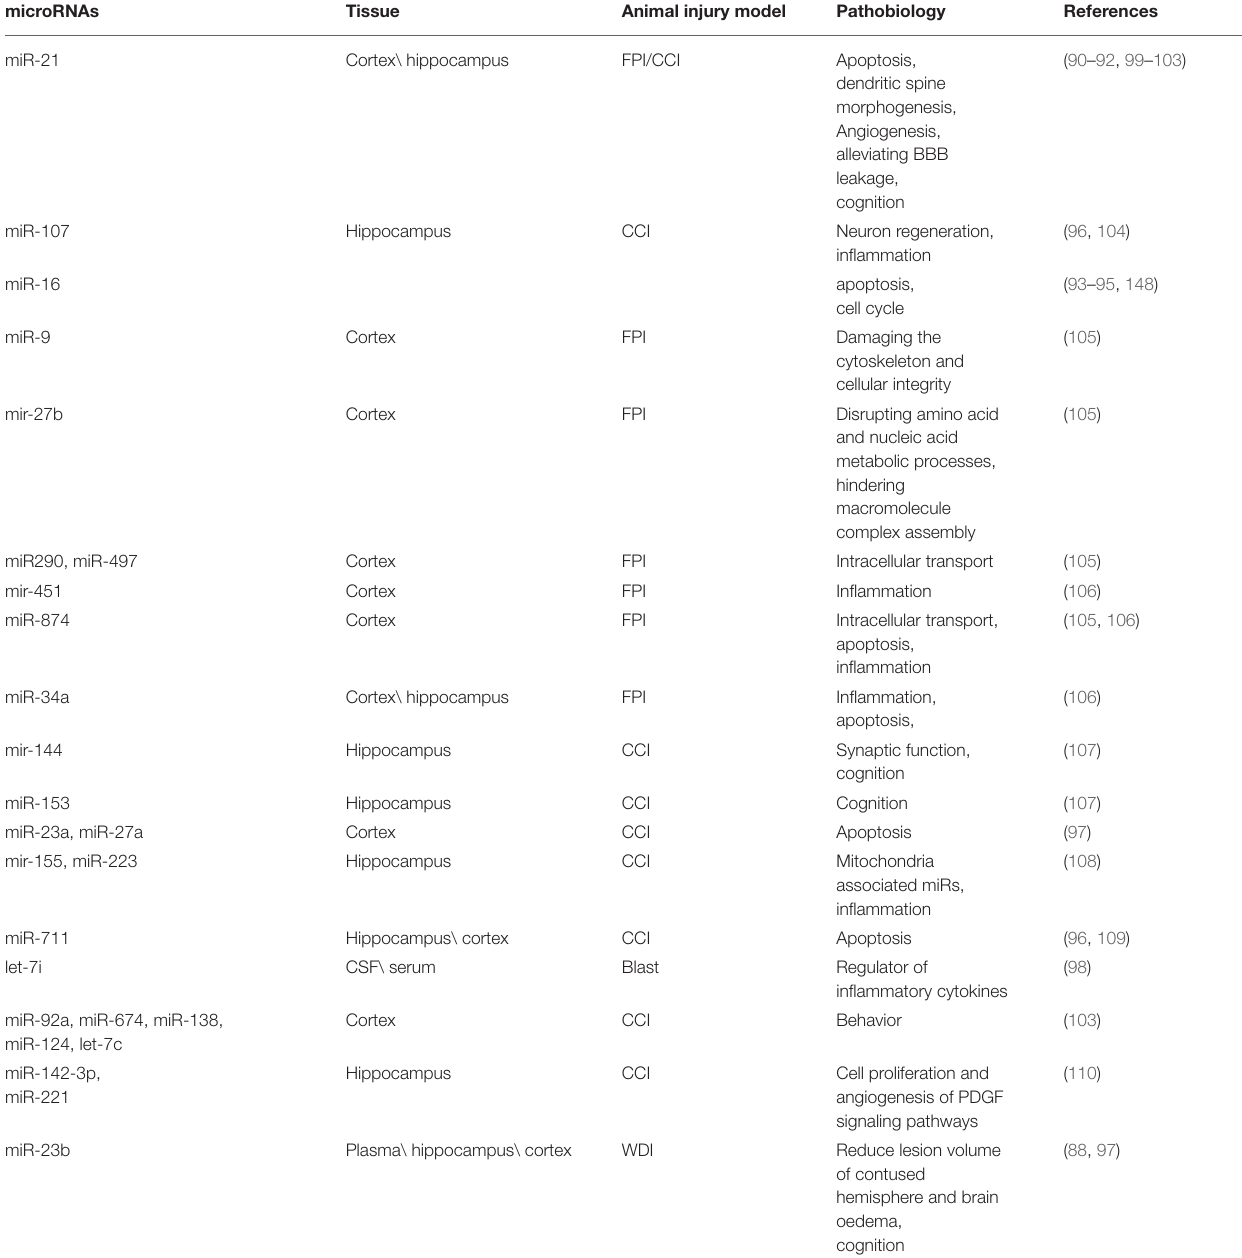
TABLE 3 | Pathobiology of the main differentially expressed microRNAs in brain of different animal injury